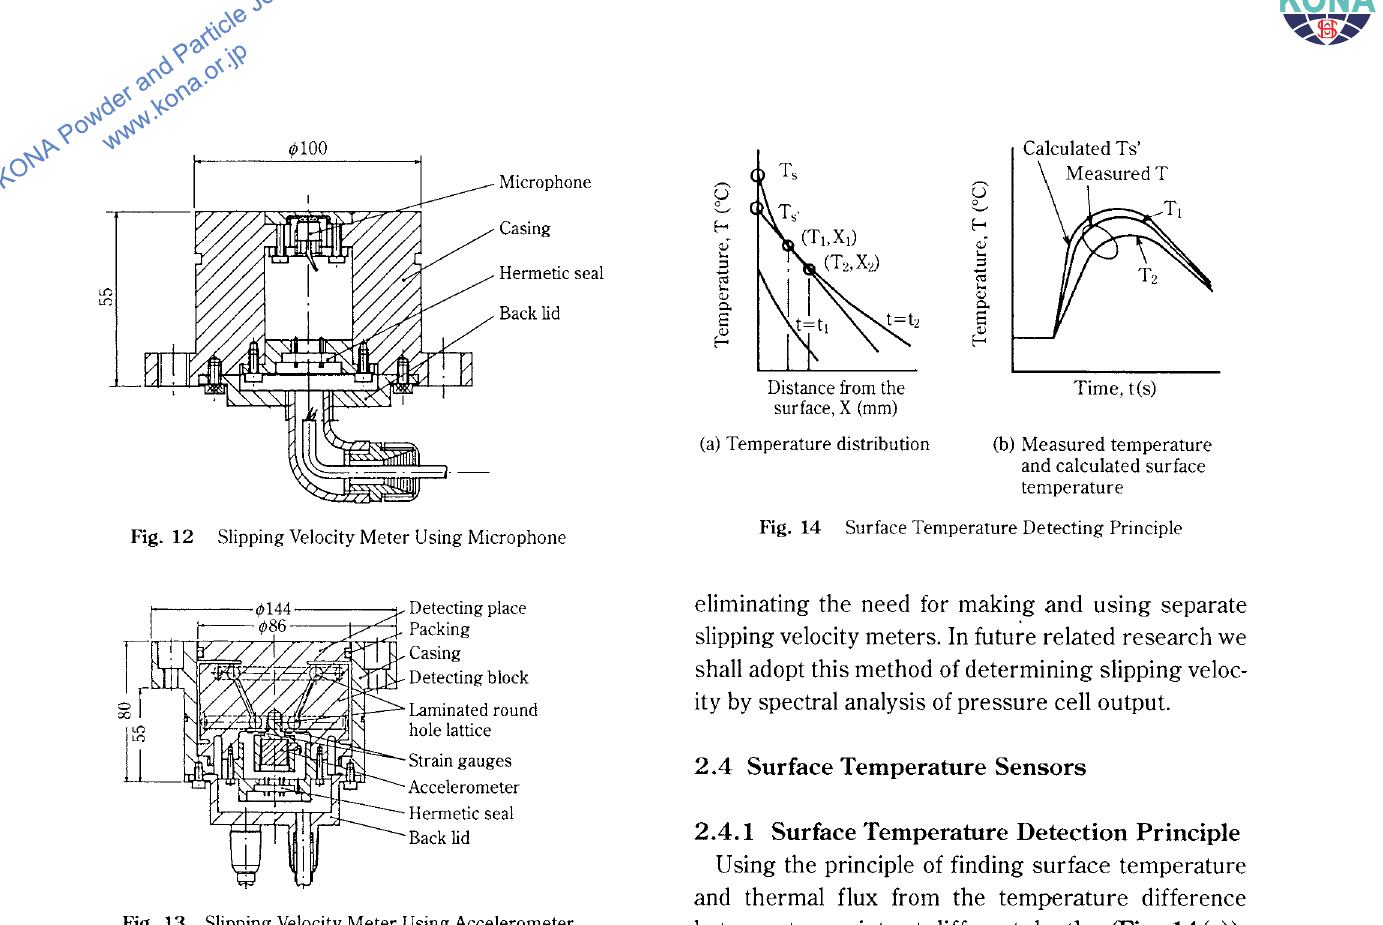
Fig. 13 Slipping Velocity Meter Using Accelerometer